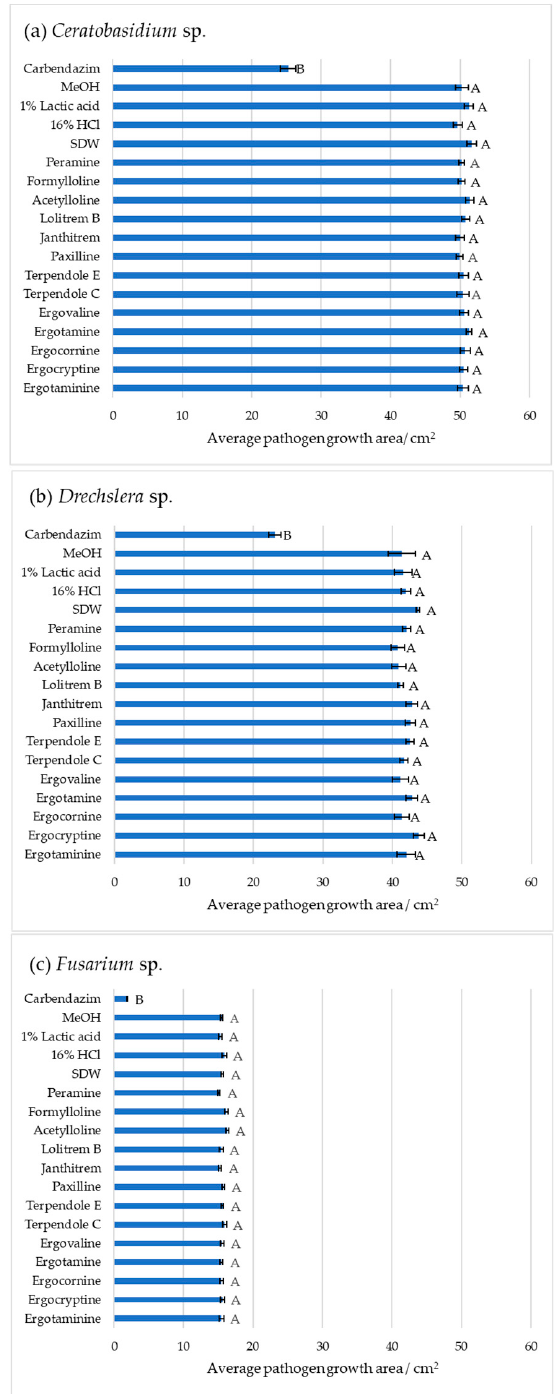
Figure 2. Pathogen growth inhibition by thirteen Epichloë sp. alkaloids and controls; carbendazim, 80% methanol (MeOH), 1% lactic acid, 16% hydrochloric acid (HCl), sterile distilled water (SDW), peramine hemisulfate (peramine), n -acetylloline.HCl (acetylloline), n -formylloline (d3) (formylloline), lolitrem B, janthitrem A, paxilline, terpendole E, terpendole C, ergovaline, ergotamine, ergocornine, ergocryptine, ergotaminine against ( a ) Ceratobasidium sp.; ( b ) Drechslera sp.; ( c ) Fusarium sp. Image analysis measured the growth area (cm 2 ) of the pathogen in the agar well diffusion assay at day six. All data are mean ± standard error, n = 5. Significance was determined by one-way ANOVA and Tukey post-hoc test for pairwise comparison; p < 0.01 indicates significant inhibition. Means that do not share a letter are significantly different. In each instance Tukey post-hoc tests grouped the positive control, carbendazim, separately to all other treatment groups.